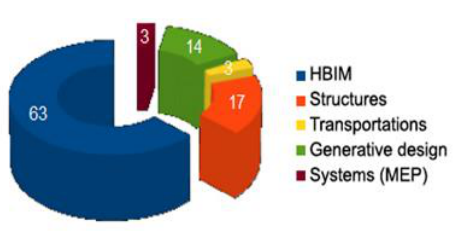
Figure 3 . Subscribers to specialized BIM modules: percentage overview (Figure by P. Fiamma).